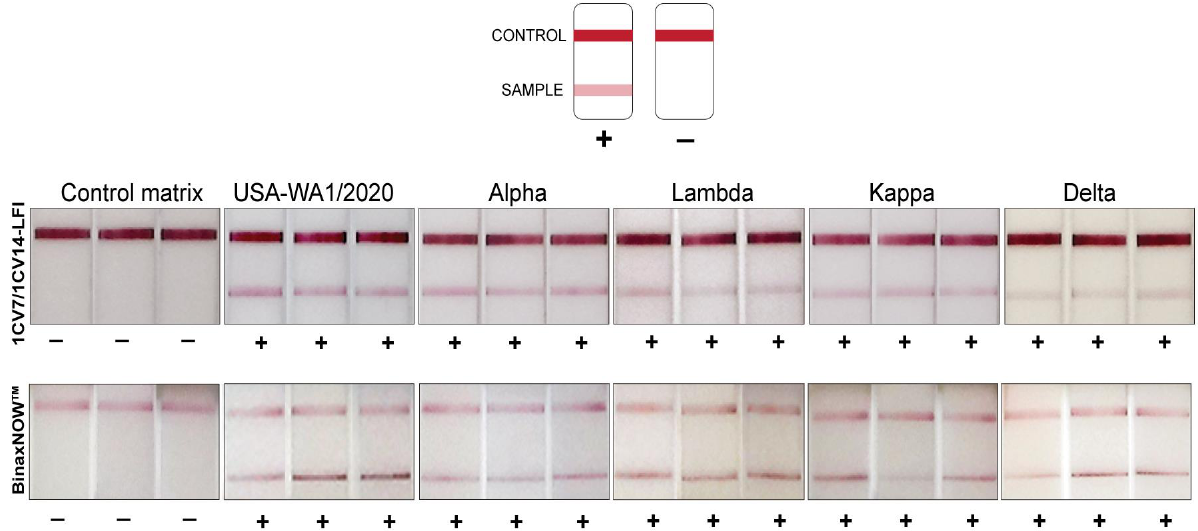
Figure 1. Schematic illustrating positive and negative LFI readings. Additionally, the performance of 1CV7/1CV14 LFI in comparison with BinaxNOW TM for the detection of SARS-CoV-2 variants at 500 TCID 50 /test. A control matrix with known amounts of live SARS-CoV-2 virus was loaded onto the 1CV7/1CV14 LFI as well as the BinaxNOW TM test in triplicates. Signals were recorded through visual inspection of the test lines.